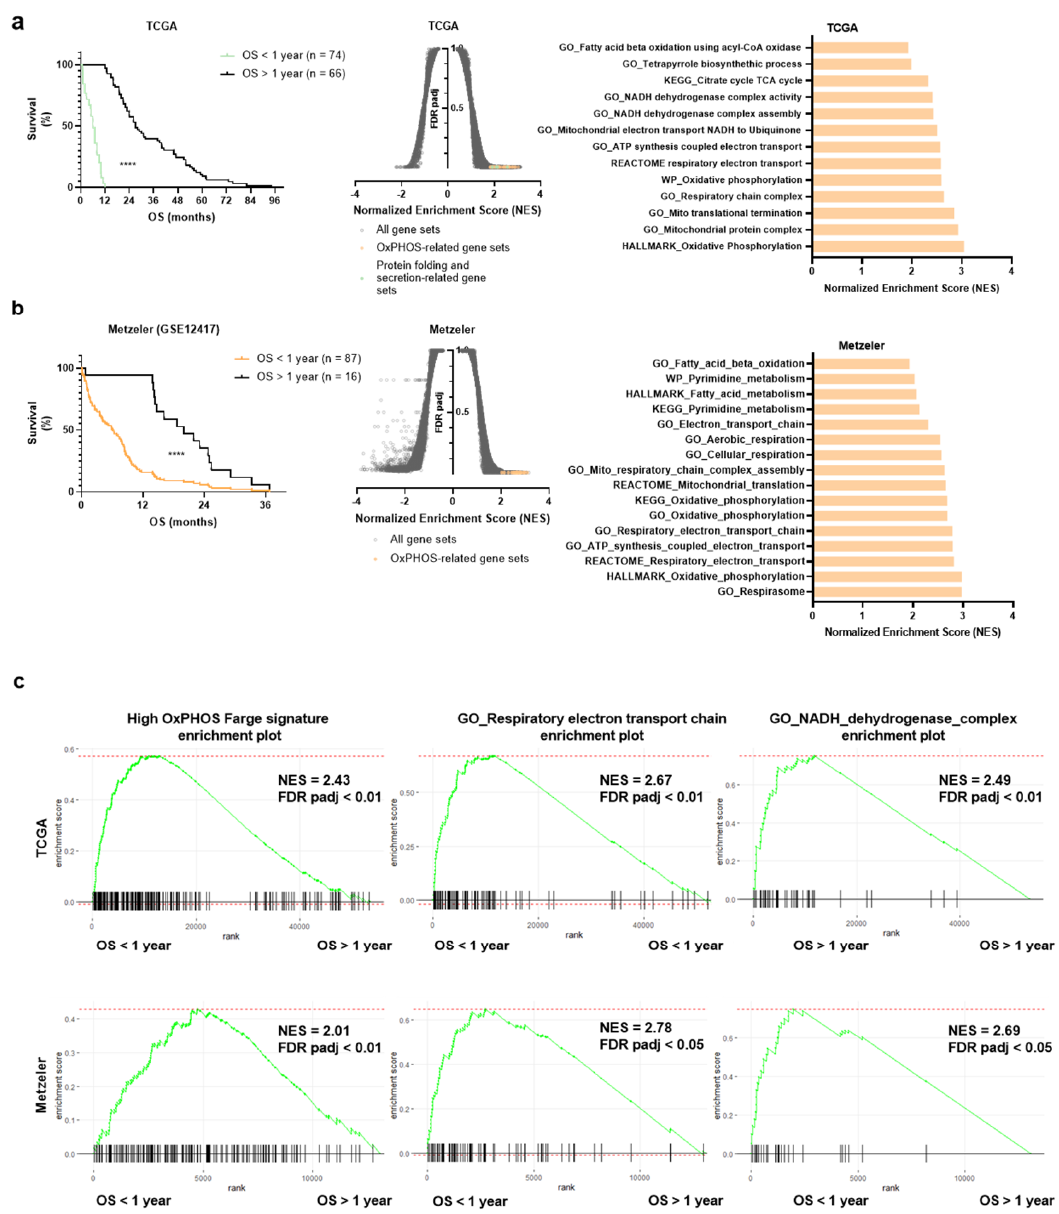
Figure 1. OxPHOS and mitochondrial gene expression is associated with a shorter overall survival in human AML. ( a ) Kaplan–Meier survival curves of the TCGA-AML cohort for patients with a short (OS > 1 year) or long (OS < 1 year) overall survival ( left ). Volcano plot showing GSEA results in the TCGA cohort comparing short vs. long survival ( middle ). OxPHOS-related gene sets enriched in the short survival group (FDR < 0.01) are highlighted in orange and protein folding and secretion-related gene sets are in green. On the ( right ), a plot showing TCGA short vs. long survival OxPHOS-related differentially expressed gene sets (FDR < 0.05) with their normalized enrichment scores (NES). ( b ) On the left, Kaplan–Meier survival curves of the Metzeler cohort for patients with a short (OS > 1 year) or long (OS < 1 year) overall survival. In the middle, the volcano plot showing GSEA results in the Metzeler cohort comparing short vs. long survival. OxPHOS